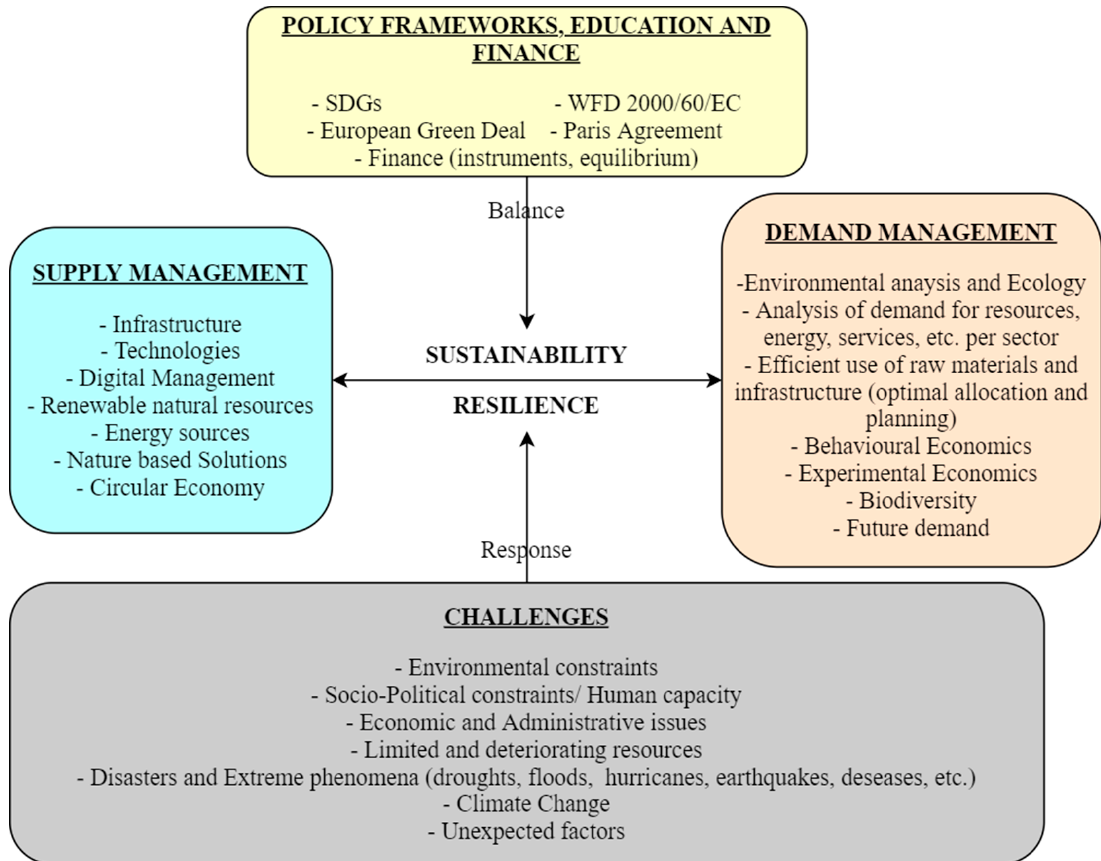
Figure 3. The most common components of the supply and demand sides, which must be balanced to achieve sustainability (environmental, economic, etc.); the challenges that our systems are facing in trying to become more resilient. The policy-finance frameworks and education will provide the necessary ground for action [31].